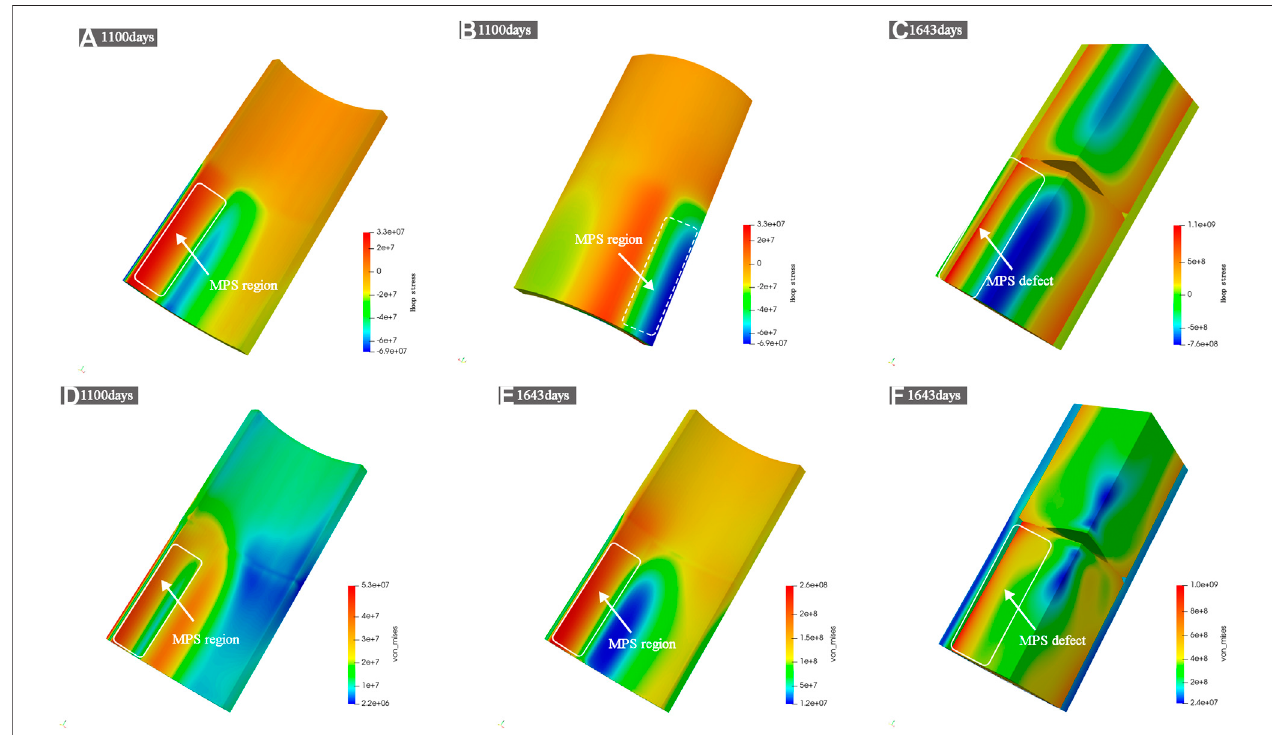
FIGURE 14 | The hoop stress distribution (A – C) and Von_mises stress distribution (D – F) in 1100 and 1643 days.